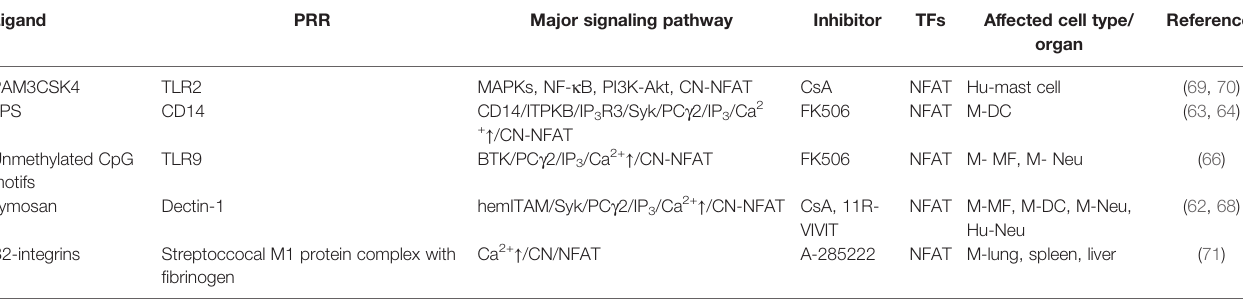
TABLE 1 | PRR expressed by neutrophils and their signaling affected by calcineurin inhibitors demonstrated in neutrophils or derived from myeloid cells. Ligand PRR Major signaling pathway